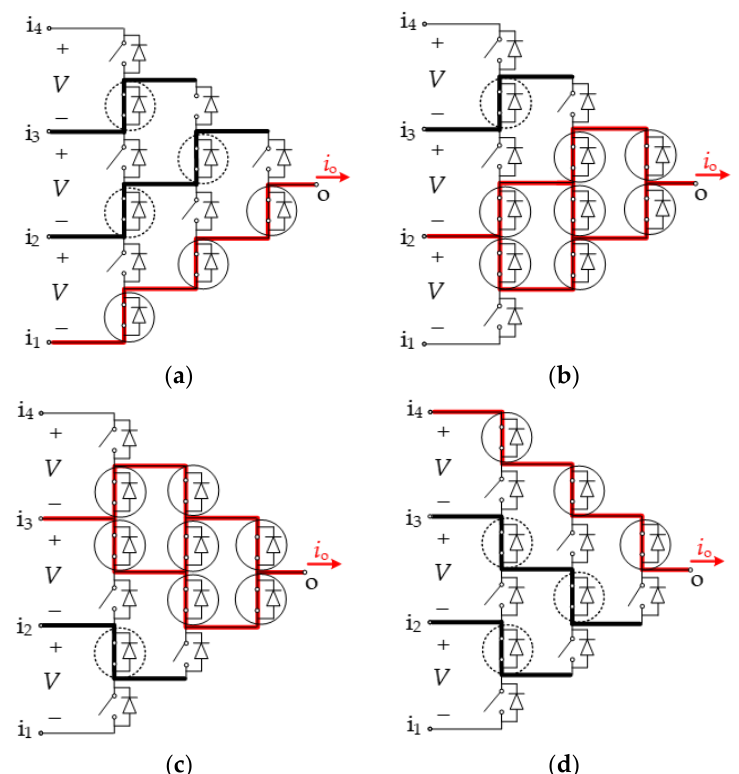
Figure 1. Four-level MAC leg switching states. ( a ) Connection to node i 1 . ( b ) Connection to node i 2 . ( c ) Connection to node i 3 . ( d ) Connection to node i 4 .